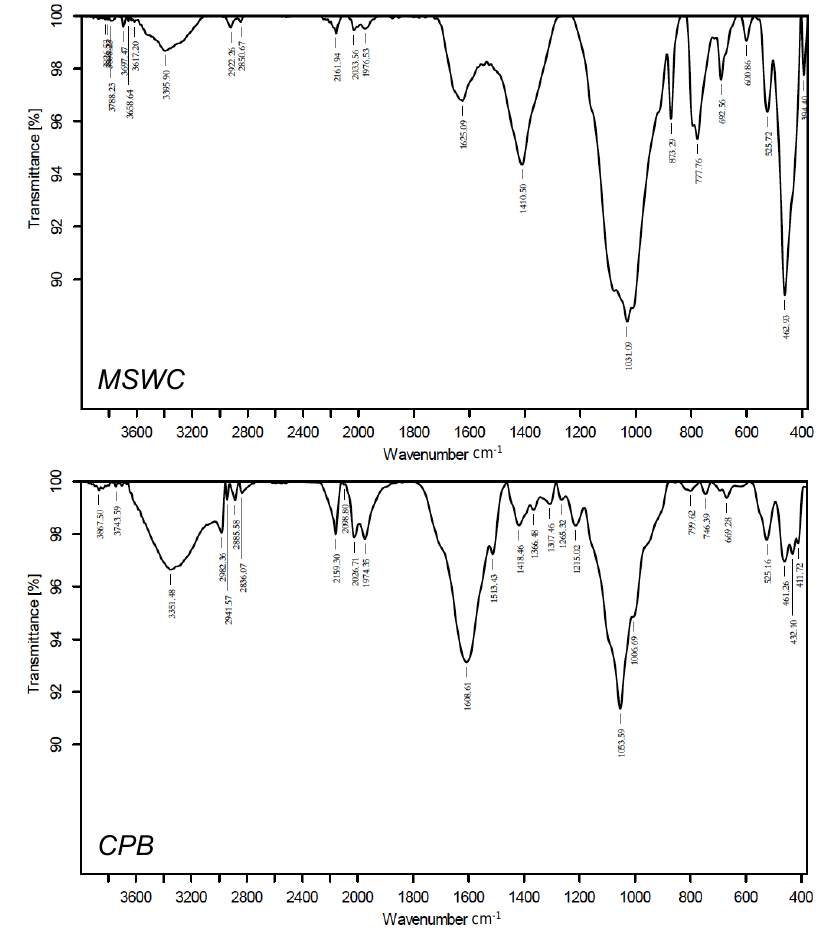
Figure 1. Fourier-transformed infrared spectroscopy (FTIR) spectra of the composts. MSWC: municipal solid waste compost; CPB: composted pine